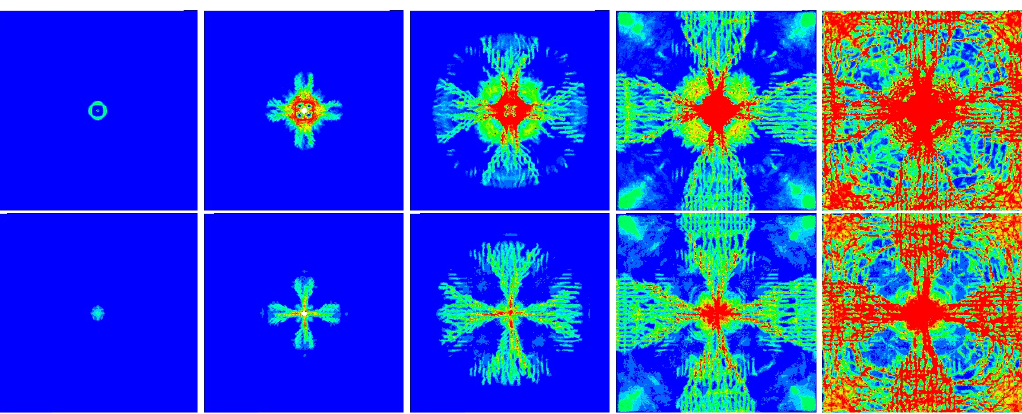
Figure 5. The time-evolution of the damage map for the top face (top row) and bottom face (bottom row) of the first layer. From left to right, snapshots taken at 9, 27, 43, 60, and 127 µ s from the contact between the projectile and the glass laminate. See movie 2 for the top face.